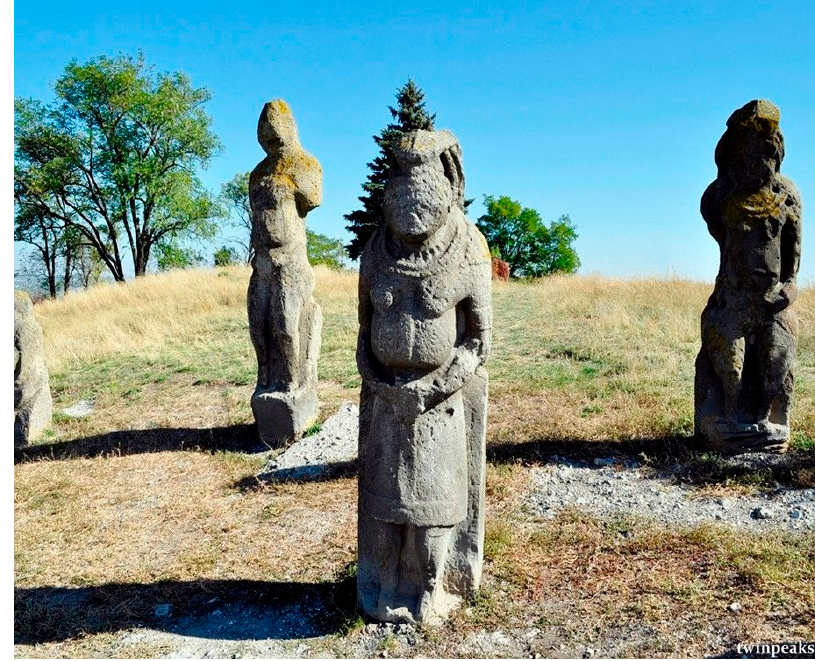
Figure 9. The babas of Polovtsy. Near Kharkiv, 12th century.